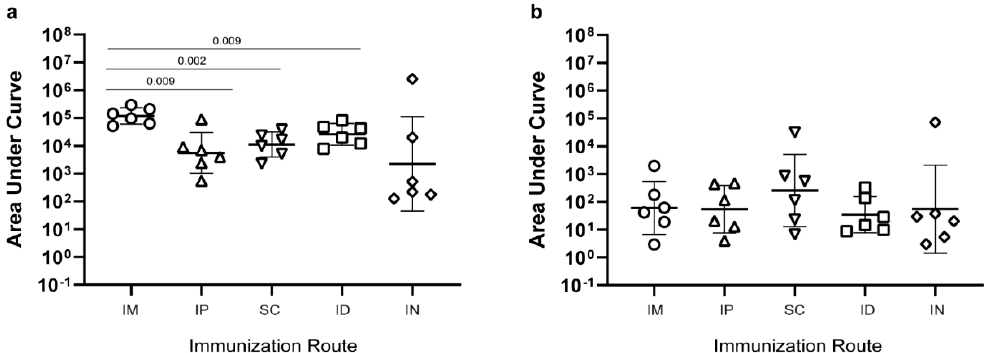
Figure 4. Immunogenicity of the SpyCatcher-AP205-L2 CLP vaccine using different immunization routes. Anti-SpyCatcher IgG ( a ) and anti-HPV L2 peptide IgG ( b ) levels were measured as the area under the curve (AUC) (i.e. optical density (O.D.) at 450 nm multiplied by the dilution factor). Groups of mice (n = 6) were immunized with an equal dose of the unadjuvanted SpyCatcher-AP205-L2 CLP vaccine administered via different immunization routes: intramuscular (IM), intradermal (ID), subcutaneous (SC), intraperitoneal (IP), and intranasal (IN). Kruskal–Wallis test showed that there was a statistically significant difference between two or more groups for SpyCatcher, p = 0.01 (panel ( a )), but not for HPV peptide, p = 0.68 (panel ( b )). For SpyCatcher, uncorrected, pairwise Mann–Whitney nonparametric tests were used to compare the IM immunized groups with the other routes of immunization. Significant differences are indicated in the graph.